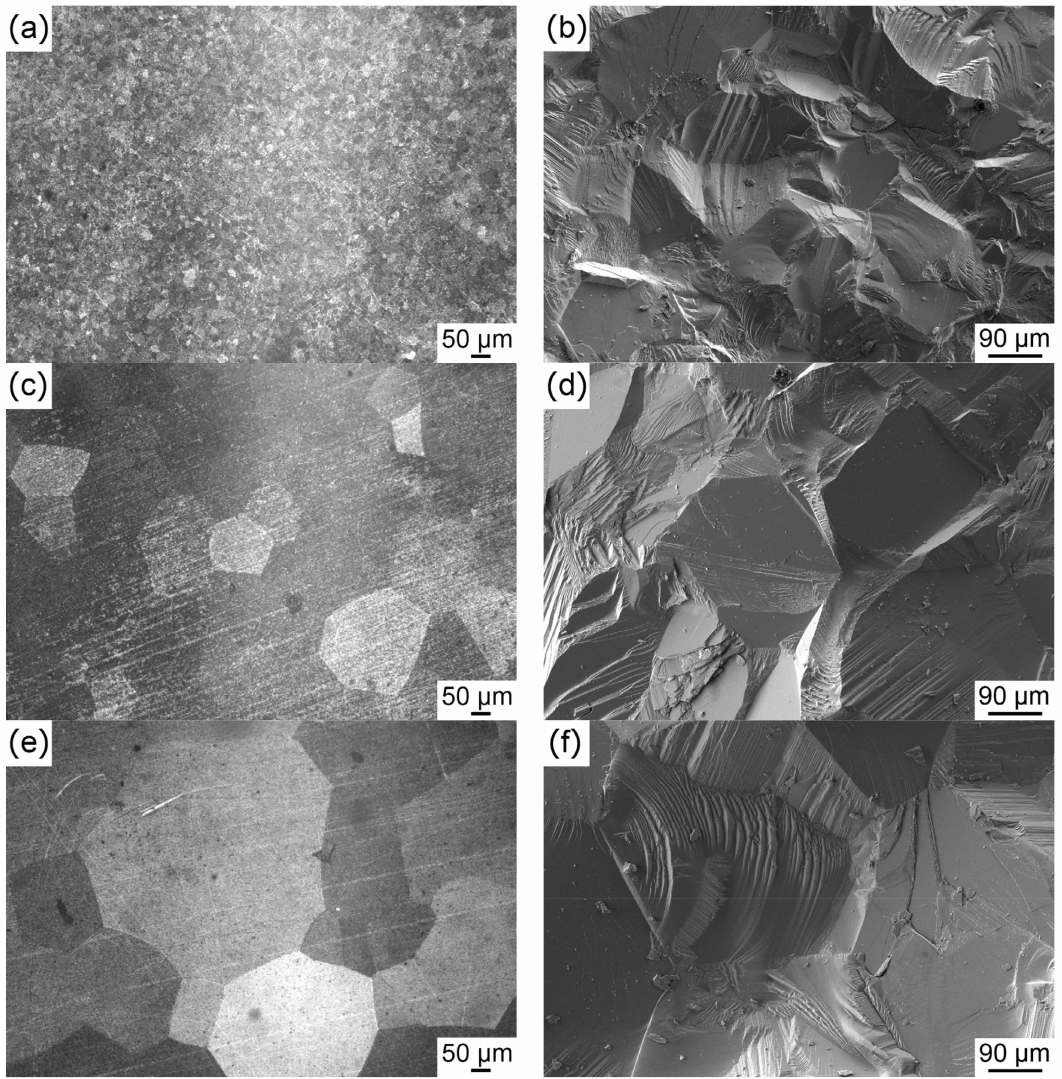
Figure 9. Optical microscopy ( a , c , e ) and FE-SEM pictures ( b , d , f ) of Dy 2 O 3 ceramics sintered at different temperatures for 10 h and air annealed at 1400 ◦ C for 10 h: ( a ) 1675 ◦ C etching surface, ( b )1675 ◦ C fracture surface, ( c ) 1780 ◦ C etching surface; ( d ) 1780 ◦ C fracture surface, ( e ) 1850 ◦ C etching surface; ( f ) 1850 ◦ C fracture